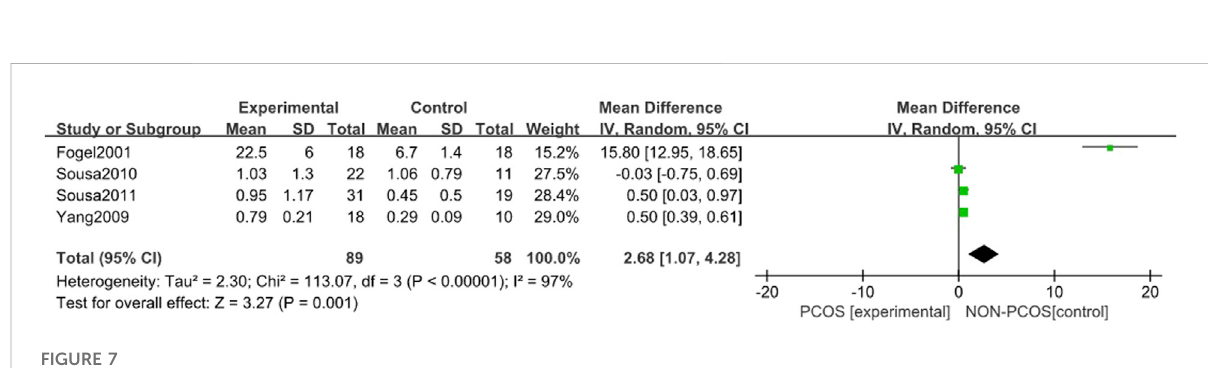
FIGURE 7 Forest plot of AHIs in PCOS group and control